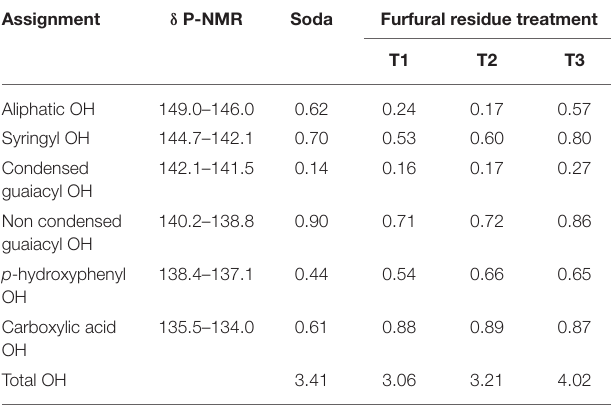
TABLE 5 | 31 P-NMR results of the extracted lignin samples